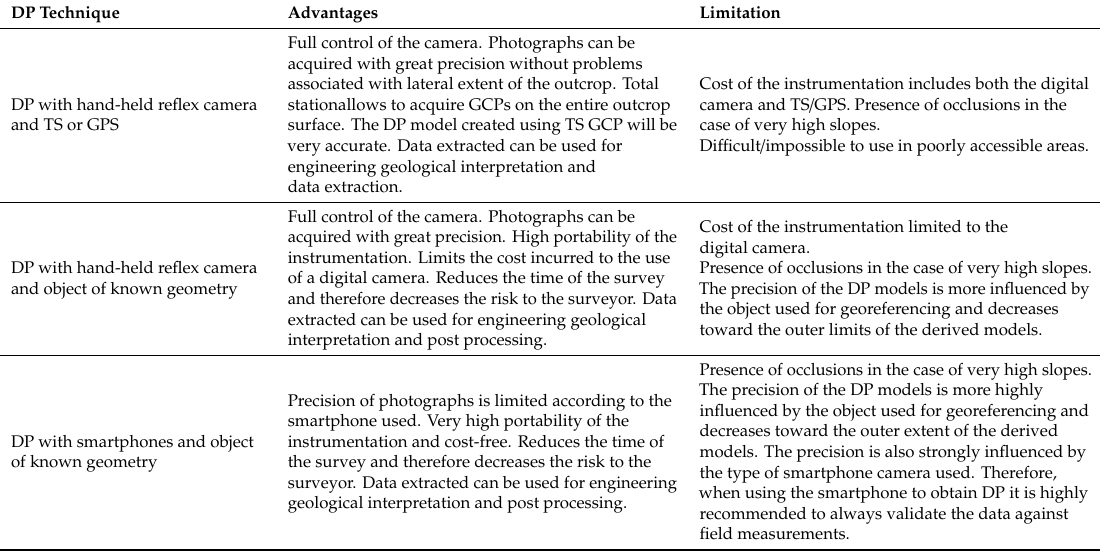
Table 4. Advantages and limitations of the di ff erent hand-held DP